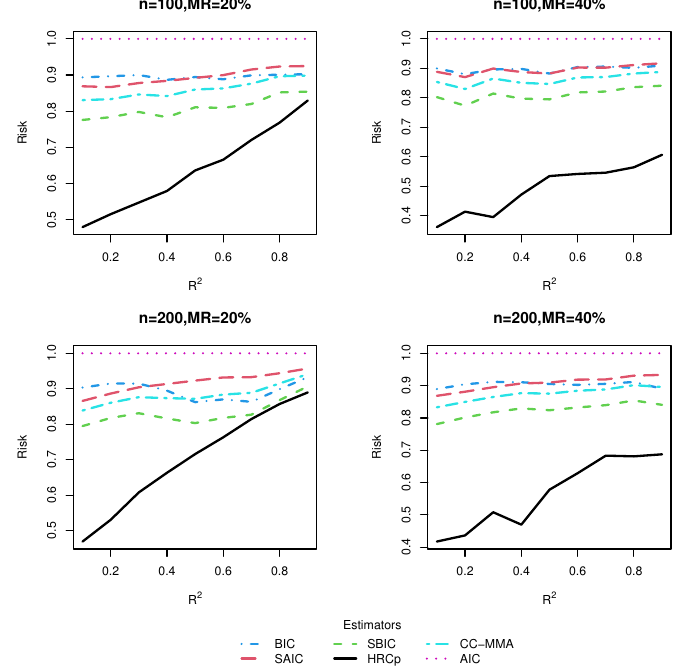
Figure 7. Risk comparisons for Design 5.